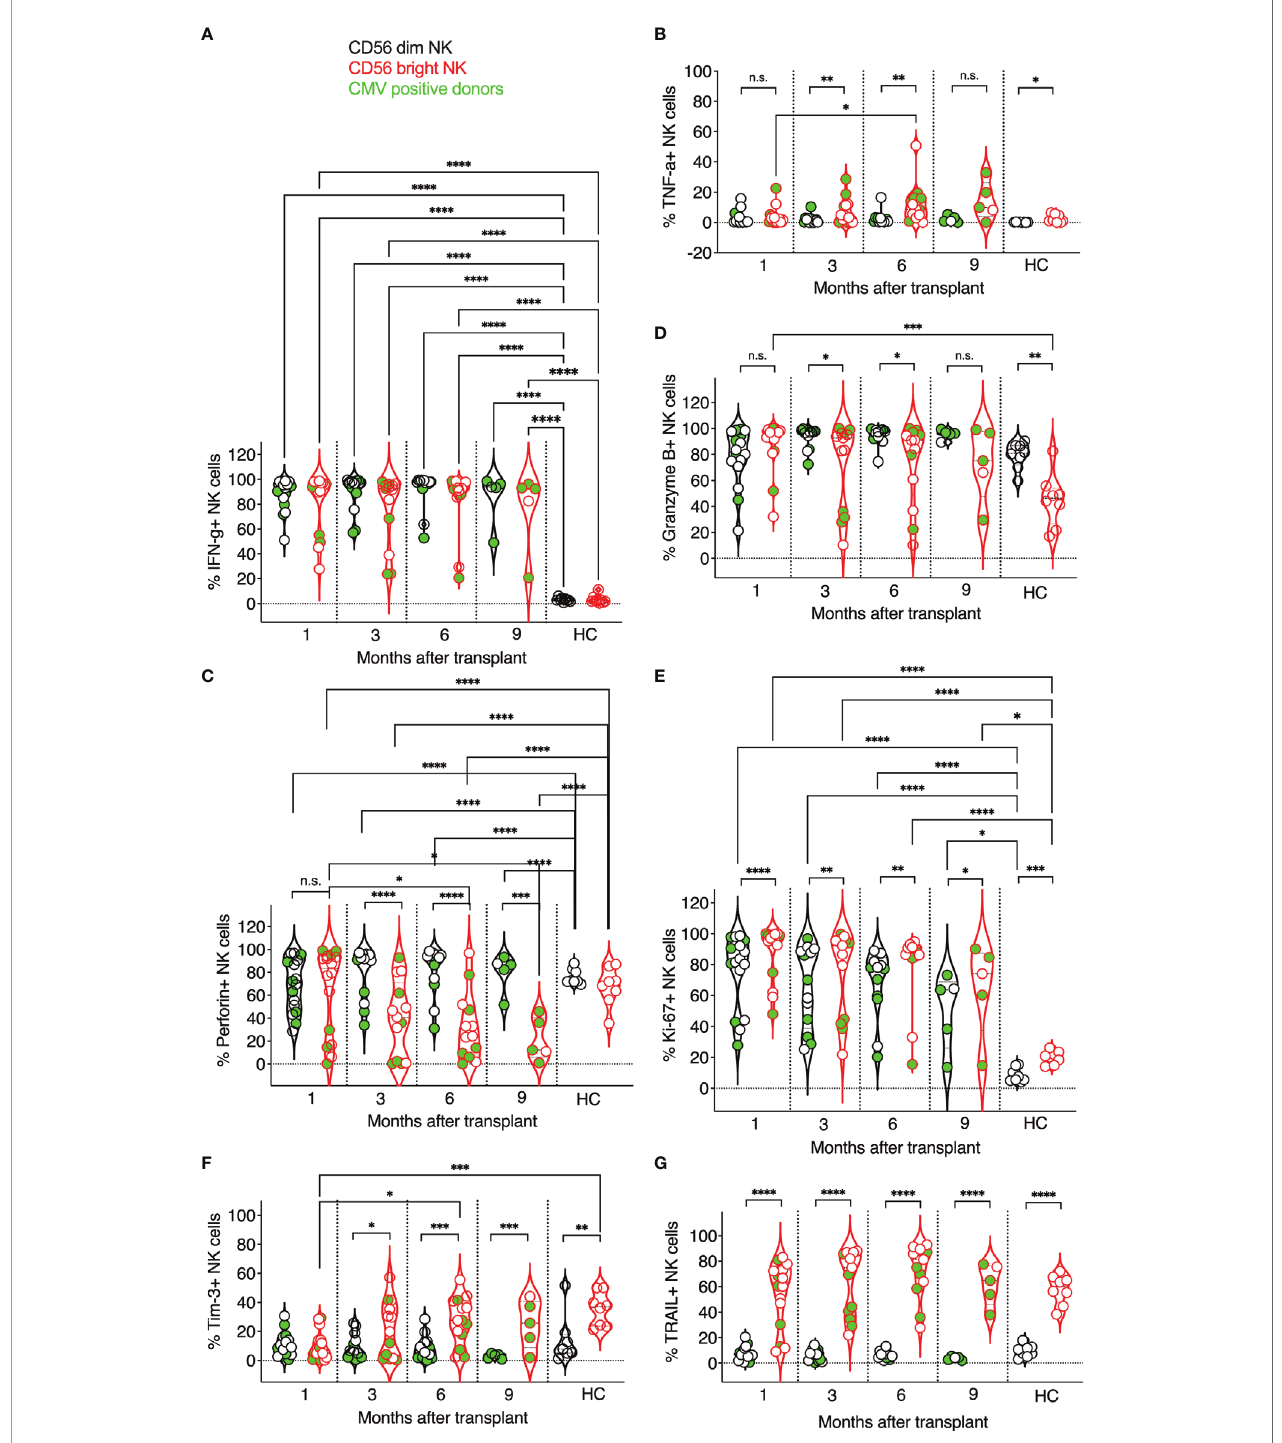
FIGURE 2 | Expression kinetics of functional markers on CD56 dim and CD56 bright NK cells post-transplant. The frequencies of functional markers (A – G) were determined for each patient ’ s circulating NK cells at indicated time points using multiparameter fl ow cytometry. Circulating healthy adult donor NK cells were also analyzed as a control. Each data point represents a single transplant recipient or healthy adult control donor (HC). Data points in black represent CD56 dim NK cells; data points in red represent CD56 bright NK cells. Data points with a neon-green fi ll color represent patients positive for CMV up to and at the analysis time as determined by quantitate PCR. *p <0.05; **p < 0.005; ***p < 0.0005; ****p <0.0005; Not signi fi cant